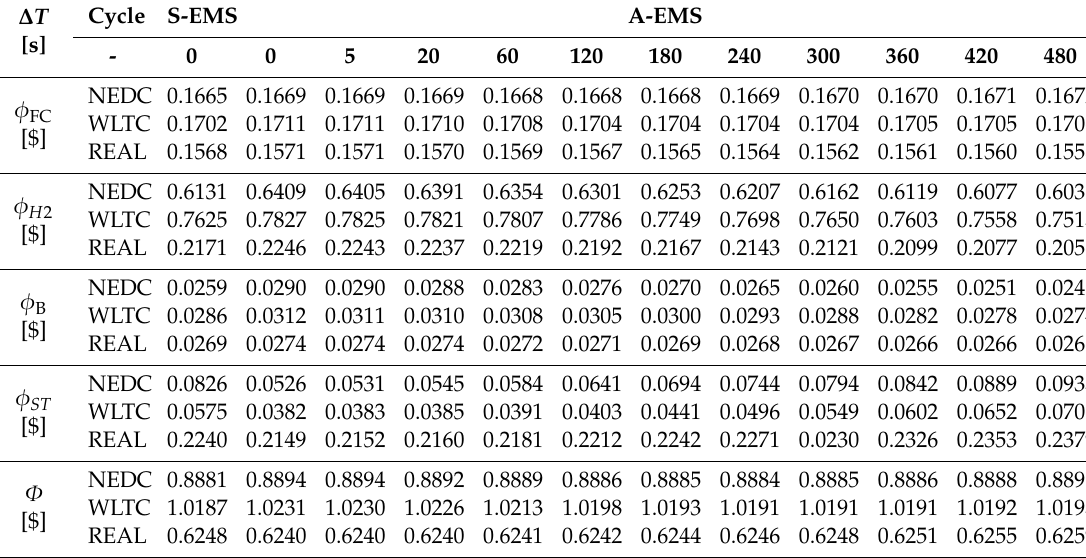
Table 2. Cost function values (S-EMS and